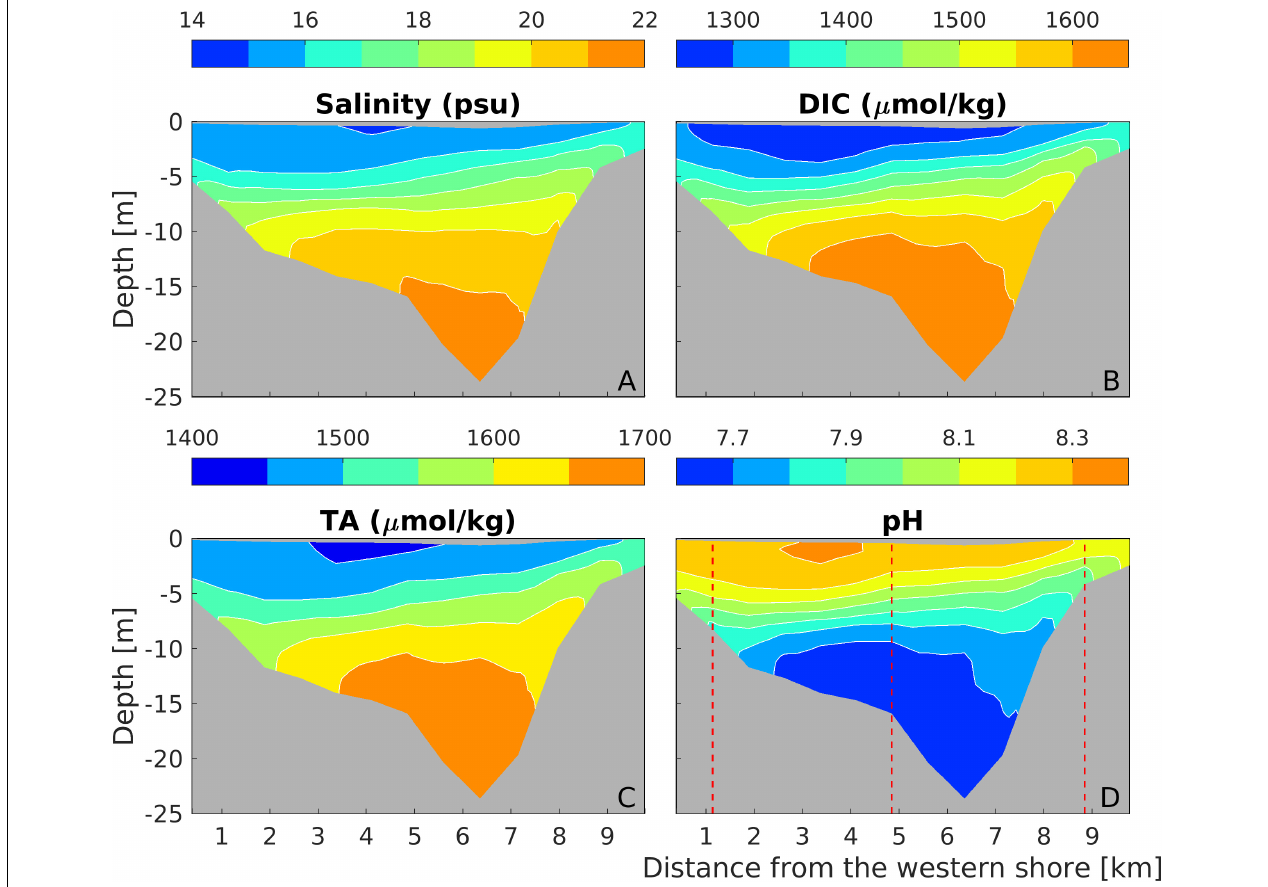
FIGURE 4 | Distributions of salinity (A) , DIC (B) , TA (C) , and pH (D) at a mid-bay cross section (marked as the thick black line in Figure 1A ) during the weak wind period. The red dashed lines in (D) mark the three stations used for plotting pH time series in Figures 2B–D